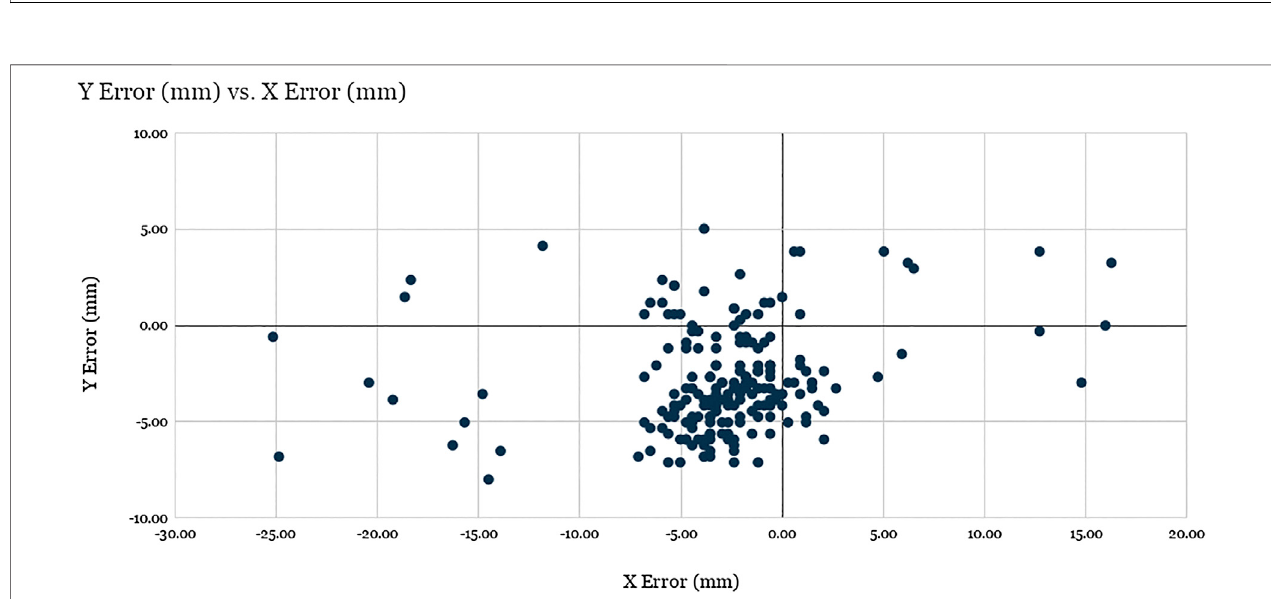
FIGURE 7 | Evaluation of robot positioning accuracy: Scatter plot of visual servoing recorded tap location errors for the 40 target locations spanning the screen across the 5 experimental runs (200 total points). See discussion.